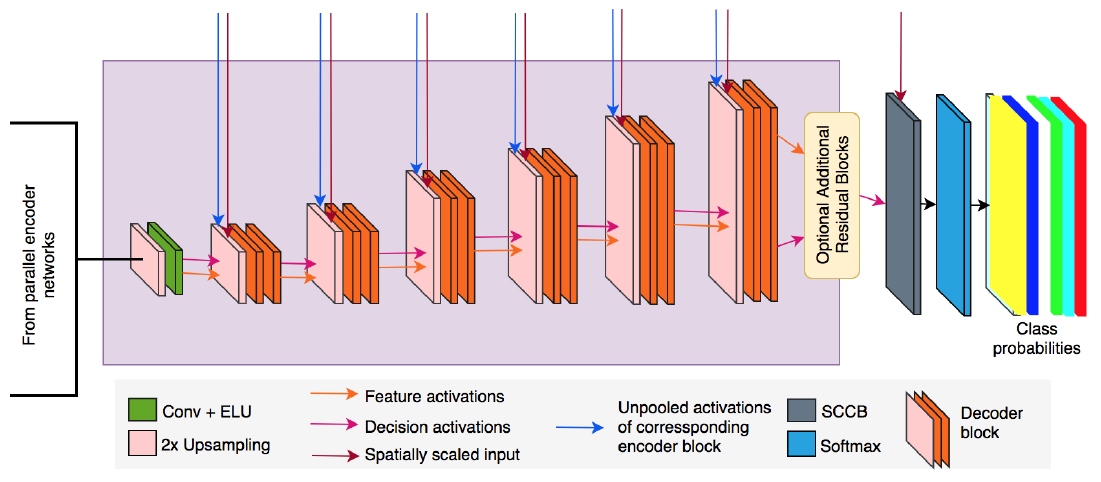
Figure 5. Decoder Connectivity